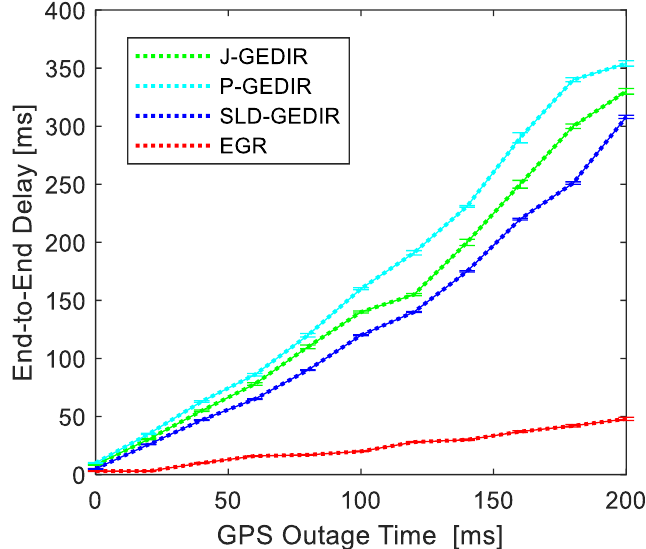
Figure 8. Effect of GPS outage on end-to-end delay.